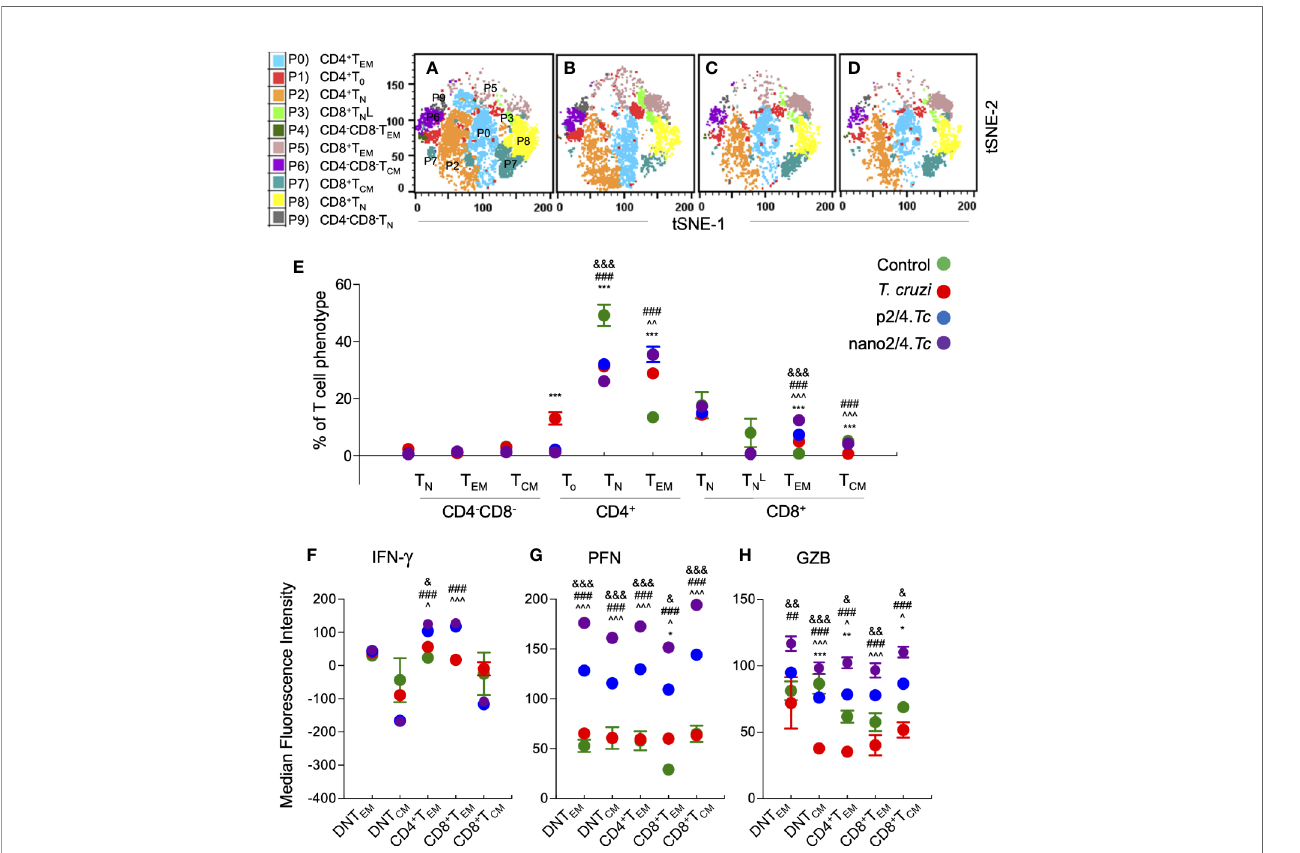
FIGURE 5 | Effect of nanovaccine on dynamics of functional activation of T cell sub-populations after re-exposure to T. cruzi . C57BL/6 mice were immunized with two doses of p2/4 or nano2/4 at 21 days interval, infected on day 21 after 2 nd vaccine dose, re-challenged on day 21 after fi rst infection, and euthanized on day 7 after re-challenge. Single cell suspensions of splenocytes were labeled with fl uorescent-conjugated antibodies and analyzed by fl ow cytometry. FlowSOM analysis of CD3 + splenic T cells of mice (1 × 10 5 live cells per mouse, n ≥ 5 per group) based on the expression levels of CD4, CD8, CD25, CD62L, and CD44 antigens generated self-organizing ten meta-clusters (referred as P0 – P9). (A – D) The tSNE (t-distributed stochastic neighbor embedding) plots were generated with non-linear reduction method to visualize all the 10 sub-populations in two-dimensional space in non-vaccinated/non-infected (A) , non-vaccinated/infected (B) , p2/4. Tc (C), and nano2/4. Tc (D) groups of mice. (E) Bar graphs show P0 – P9 sub-populations of T cells in four groups of mice. (F – H) Median fl uorescent intensity was calculated for intracellular cytokine (IFN- g ) and markers of T cell cytotoxicity [perforin (PFN) and granzyme B (GZB)] in T central memory (T CM ) and T effector/effector memory (T EM ) subsets. All data are derived from n ≥ 5 mice per group ( ≥ 2 observations per sample) and plotted as mean values ± SEM. Signi fi cance is presented as described in Figure 1 . Detailed data (mean values ± SEM and signi fi cance) are shown in Tables S2C and S3C